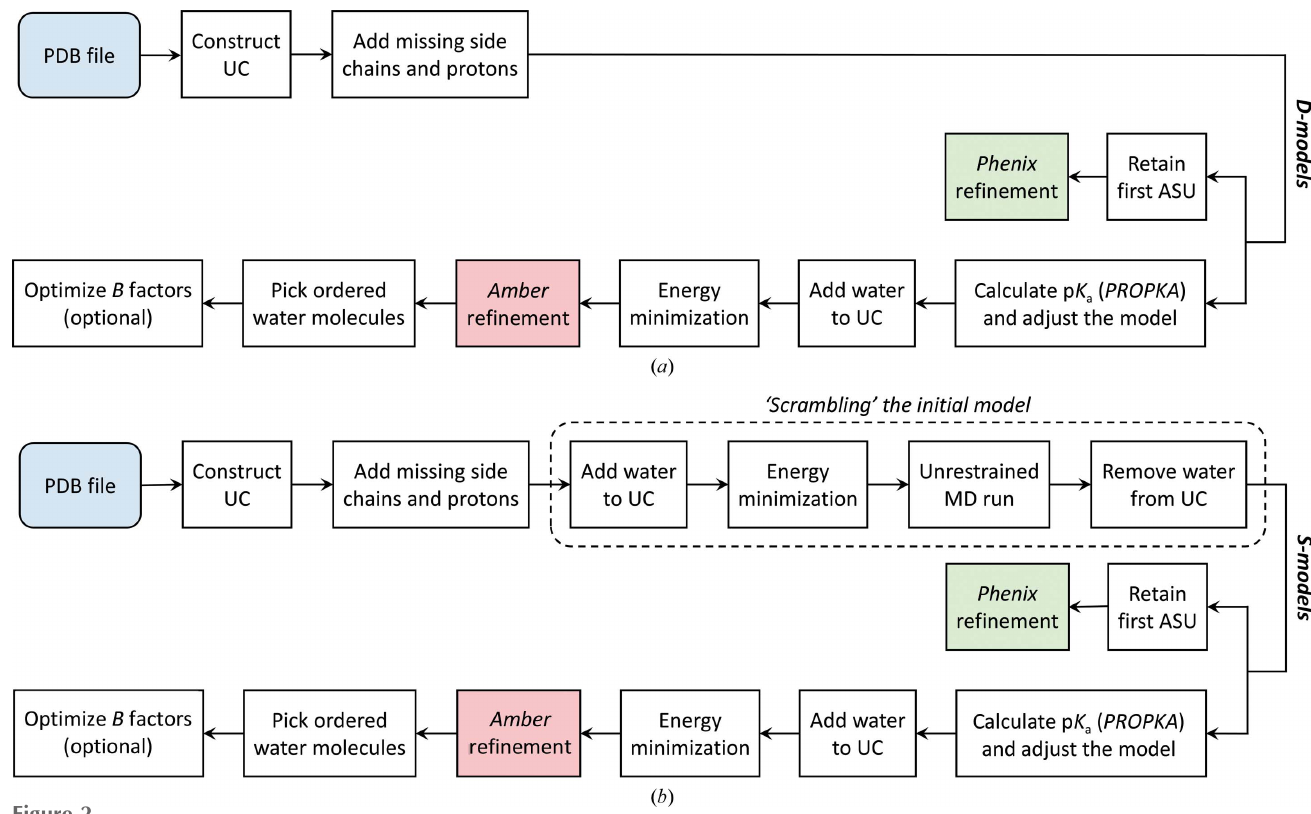
Figure 2 Pipeline for Amber -based refinement (with Phenix -based refinement included for the purpose of comparison). ( a ) Initial models are obtained directly from the deposited crystallographic structures (the D-set). ( b ) Initial models are from crystallographic structures subjected to a short MD run, i.e. intentionally ‘scrambled’ (the